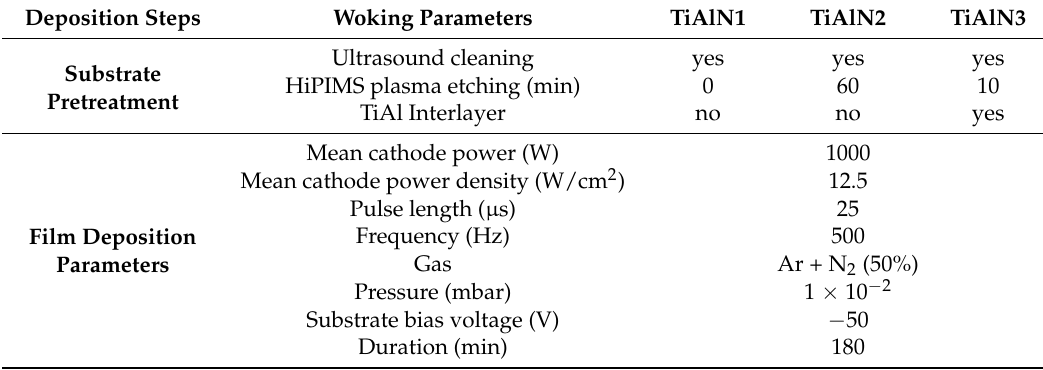
Table 1. HiPIMS pretreatment and working parameters set for TiAlN coating